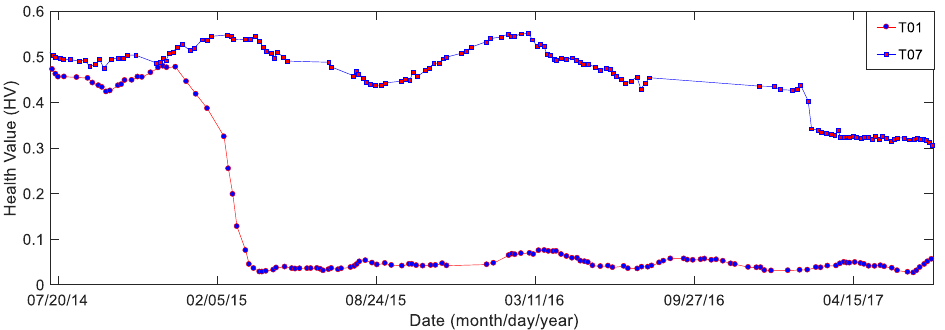
Figure 14. Comparison of two wind turbines.